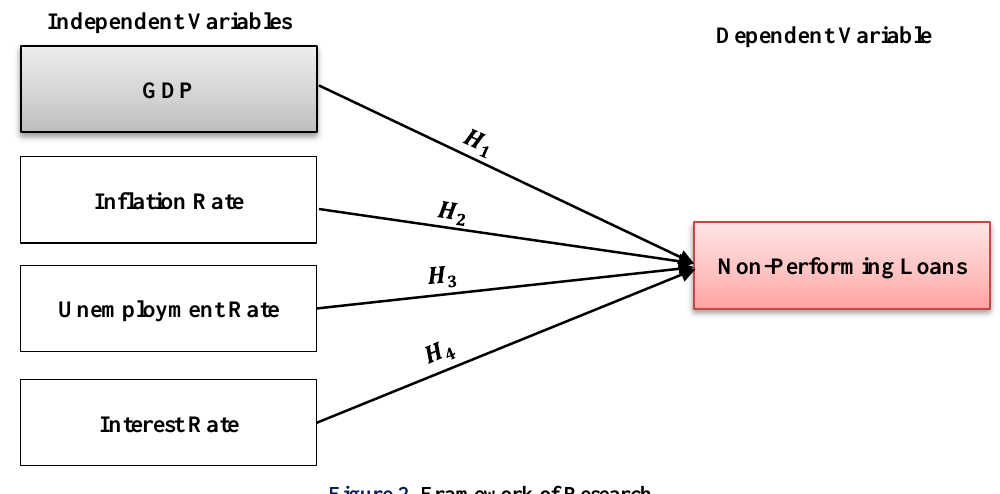
Figure 2. Framework of